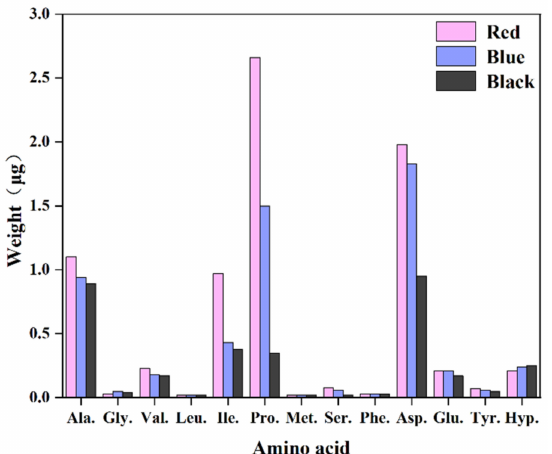
Figure 7. The amino acid contents of the pigments (red, blue, and